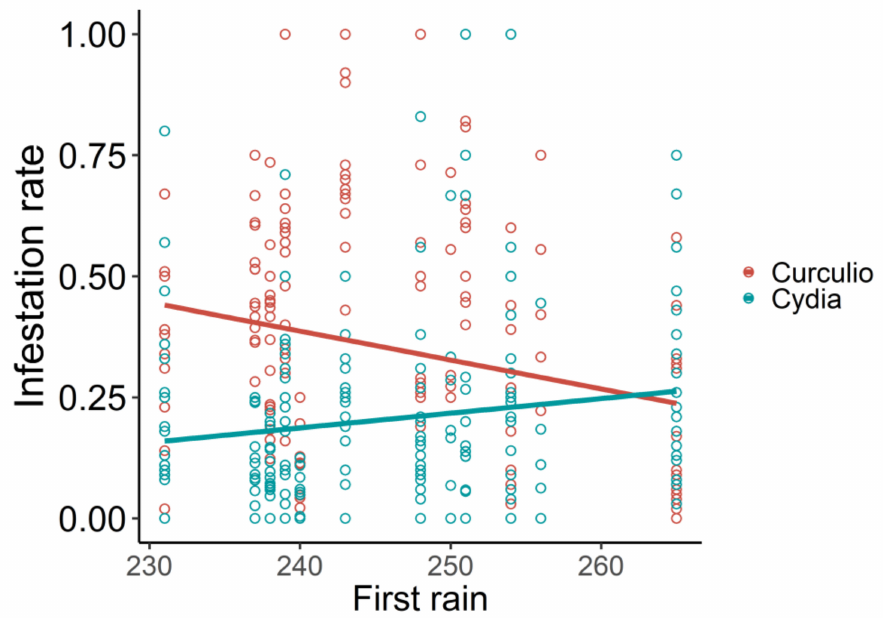
Figure 6. Relationship between the date of the first late summer rains and acorn infestation rates by Curculio and Cydia . First late summer rain is the date from 4 August onwards in which at least a daily precipitation of 1 L/m 2 was recorded. Julian dates (day 1 = 1 January) are